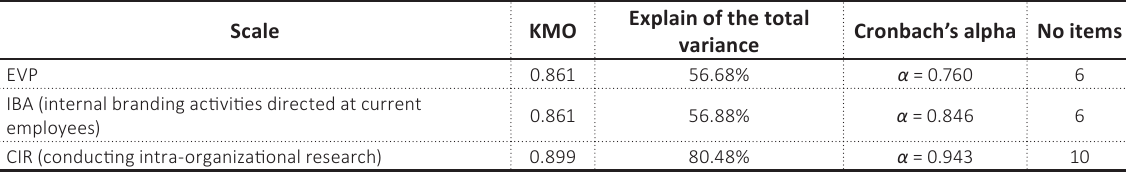
Table 4. The reliability of the scale